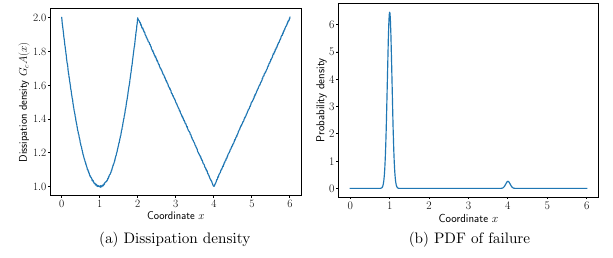
Fig. 33 Single edge notched specimen. Dissipated fracture energy in Mode I and Mode II for the unperturbed model